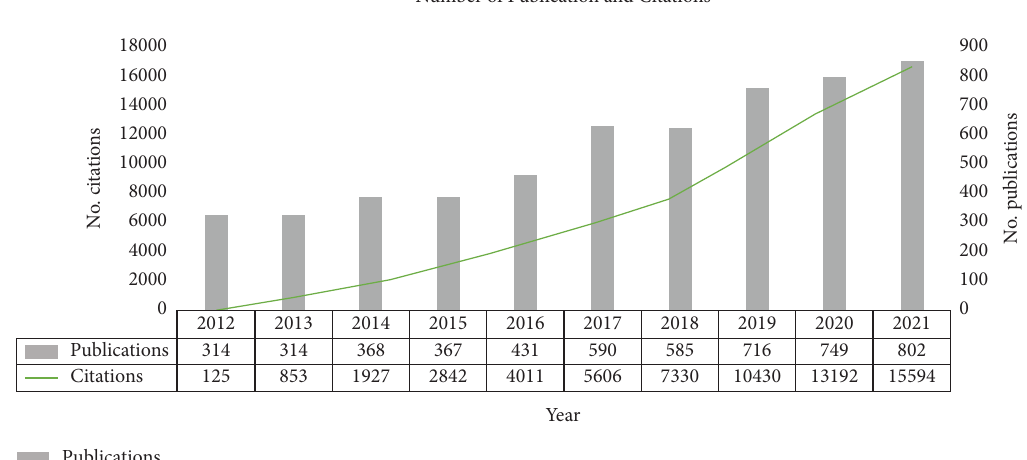
Figure 2: Absolute numbers of publications related to acute postsurgical pain and numbers of citations to those publications, 2012–2021. Notes: the data has been taken from the publication year to the retrieved date (February 10,